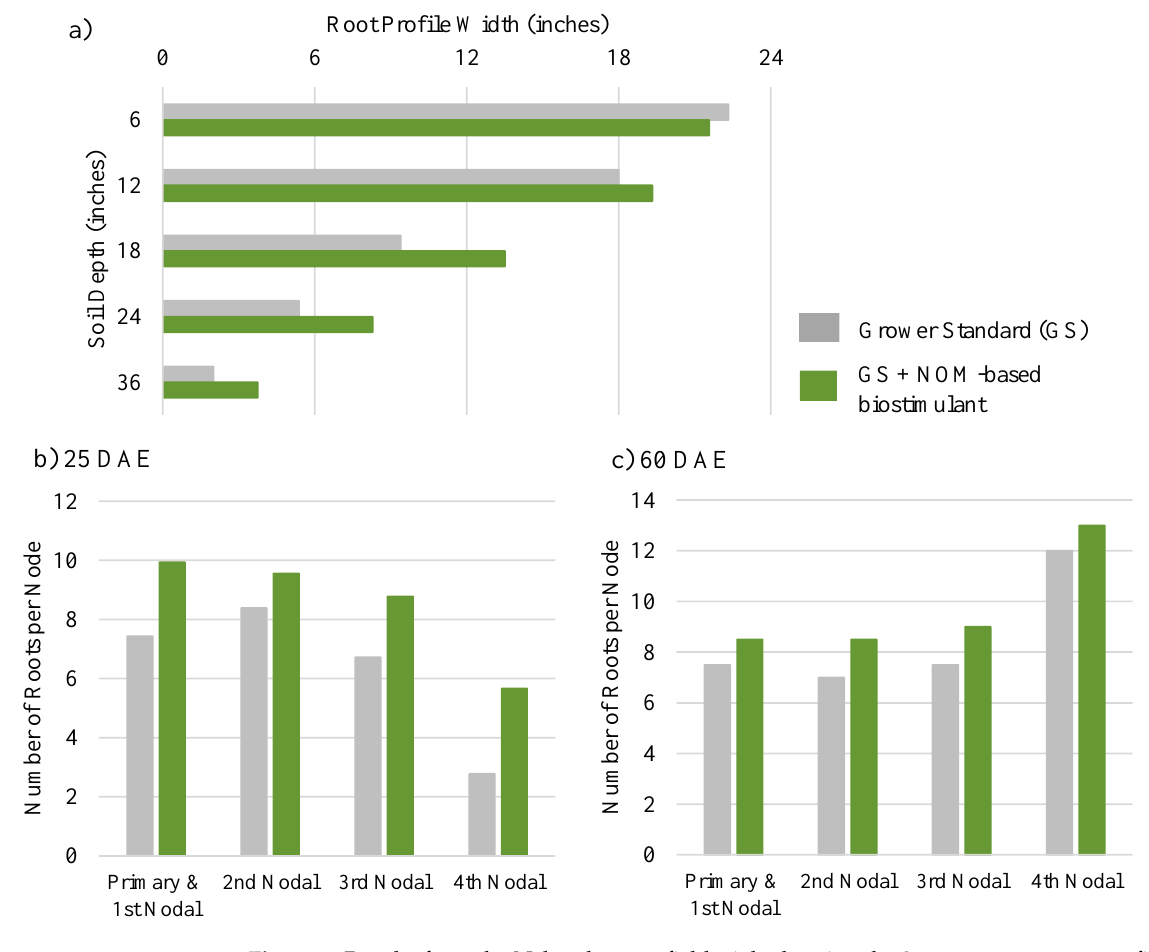
Figure 7. Results from the Nebraska corn field trials showing the 3-year average root profile width with soil depth (panel a ) and the 3-year average number of roots per node at 25 (panel b ) and 60 (panel c ) days after emergence (DAE).